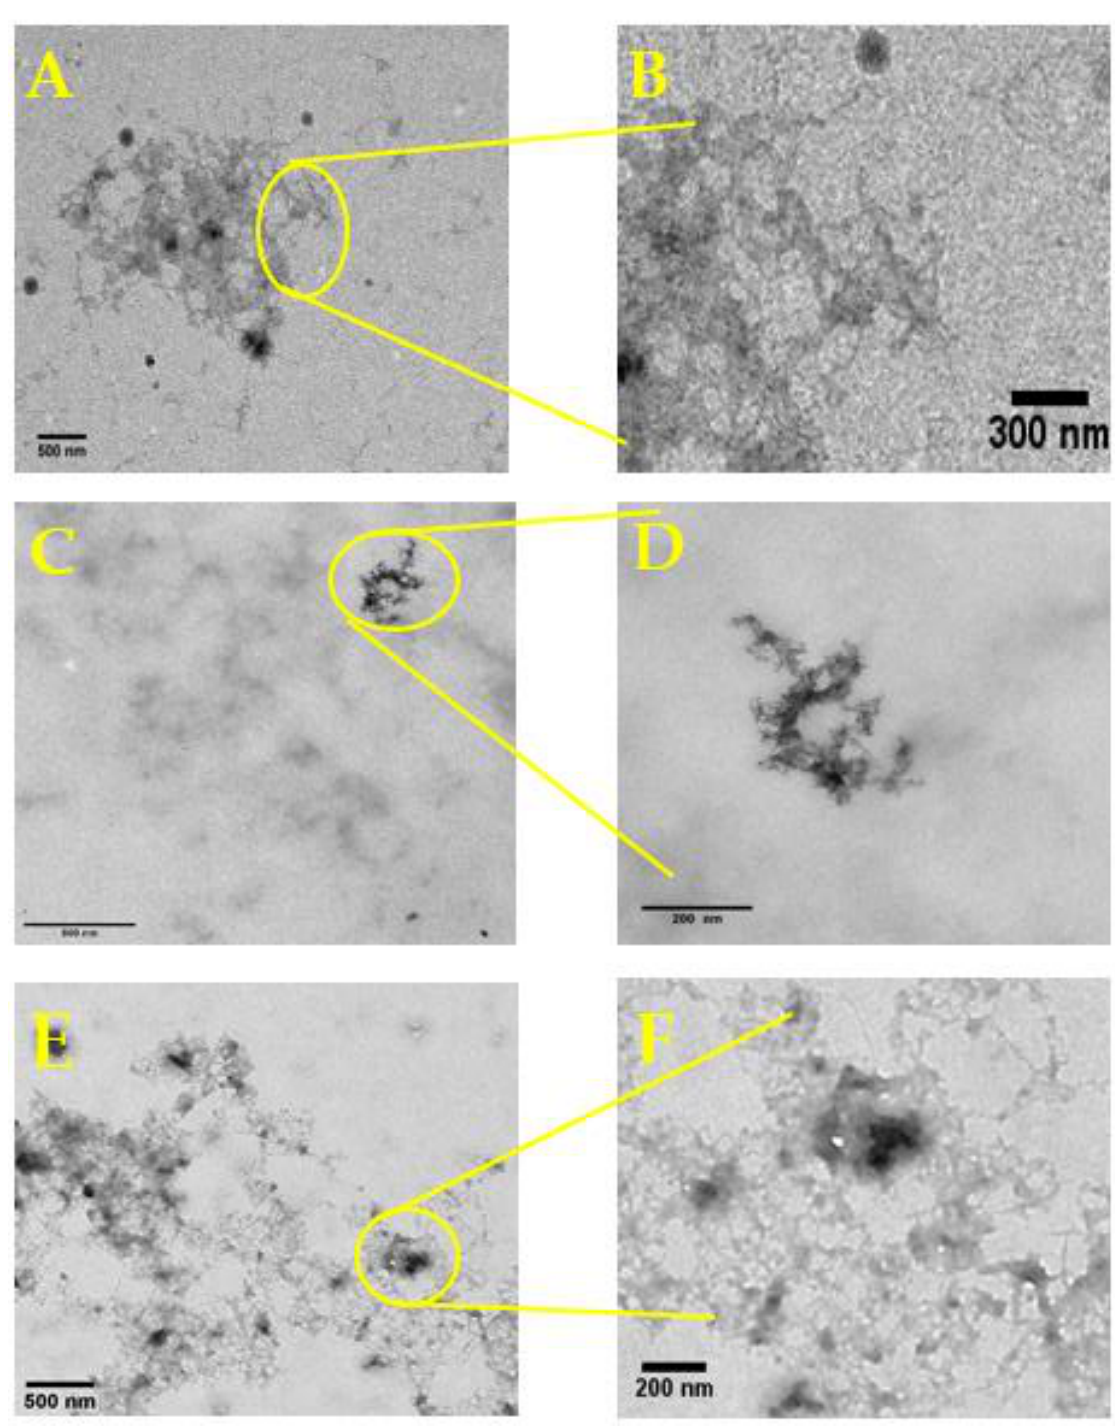
Figure 1. TEM investigation of poplar sourced cellulose nanocrystals (CNC). ( A , B ) depict CNC after 5 min of hydrolysis; ( C , D ) depict CNC after 10 min of hydrolysis, and ( E , F ) depict CNC after 15 min of